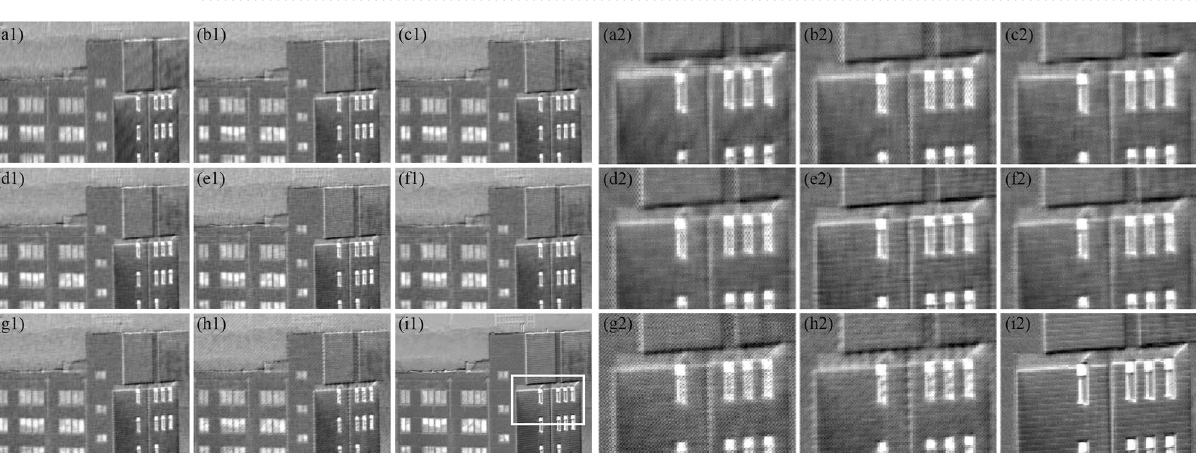
Figure 4. Reconstructed DoLP images of different MPA patterns on the building2 scene. The left side represents the ( a1 ) 2 × 2, ( b1 ) 2 × 4, ( c1 ) 2 × 3, ( d1 ) 2 × 7, ( e1 ) 2 × 2 × 2, ( f1 ) 3 × 3, ( g1 ) 5 × 5, ( h1 ) 7 × 7, and ( i1 ) ground-truth. The right side gives the enlarged views of white rectangular regions of the reconstructed images and ground-truth image according to MPAs in the left